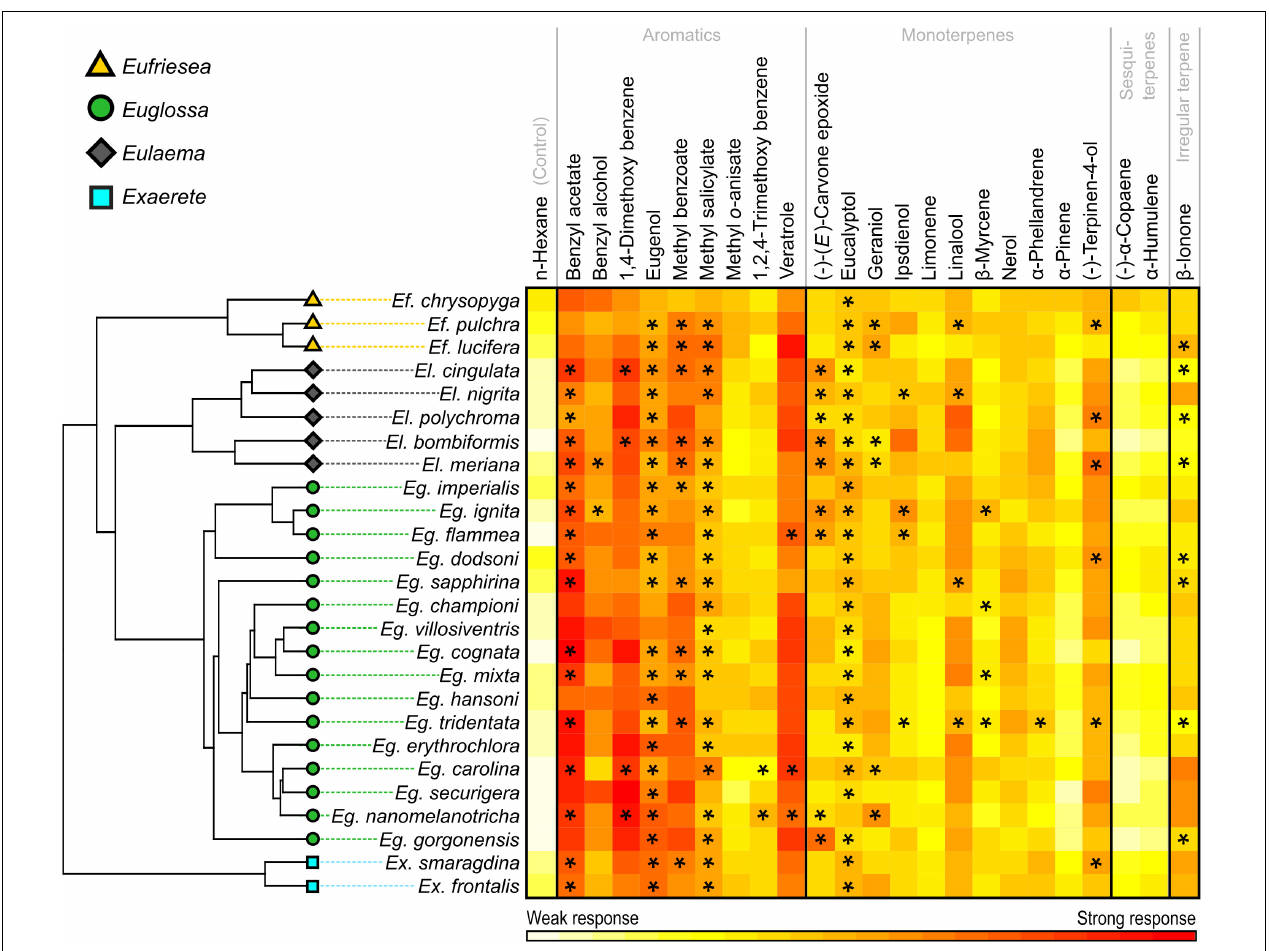
FIGURE 5 | Phylogenetic relationships of euglossine bee species based on data available for 26 of our 29 tested euglossine species (Ramírez et al., 2010b) included in this study along with a heatmap of the standardized antennal response profiles (standardized responses in percent). Colors indicate relative values of antennal strength to different chemical compounds, ranging from weak (bright yellow) to strong (deep red) responses. *Chemicals known to act as attractants for species; see also Table 1